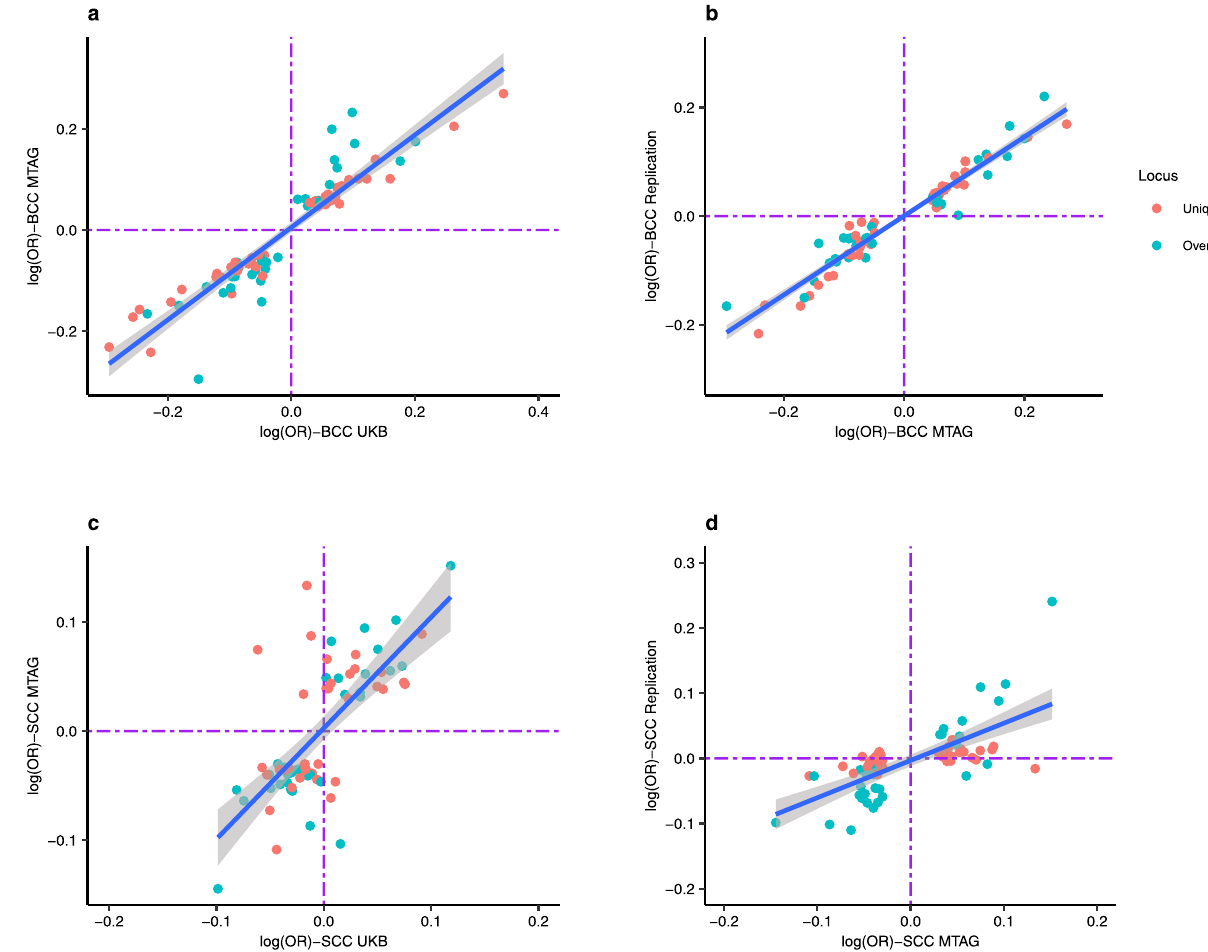
(Table2),respectively.Thepreviouslyunknownlociwereannotatedto the pigmentation, cardiometabolic, cancer development/progression and immune-regulatory pathways (Figs. 5, 6), whilst others are known loci for cutaneous melanoma susceptibility ( ATM , and SOX6 for BCC, and GPR98 , and DSTYK for both BCC and SCC). More details on these loci and the broader biological groups have been discussed in the Supplementary Information (Supplementary Note 1). For loci that are unique to BCC or SCC, or overlap between BCC and SCC, refer to Tables 1, 2.